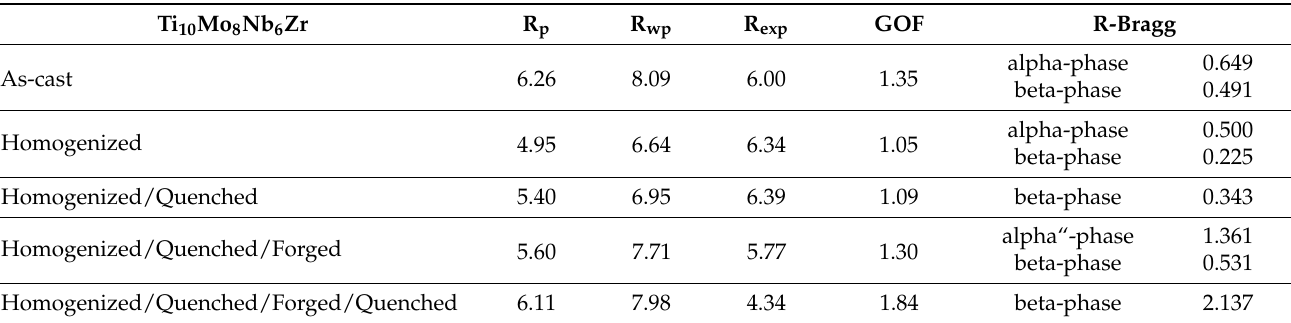
Table 2. Quality parameters of the Rietveld refinement.